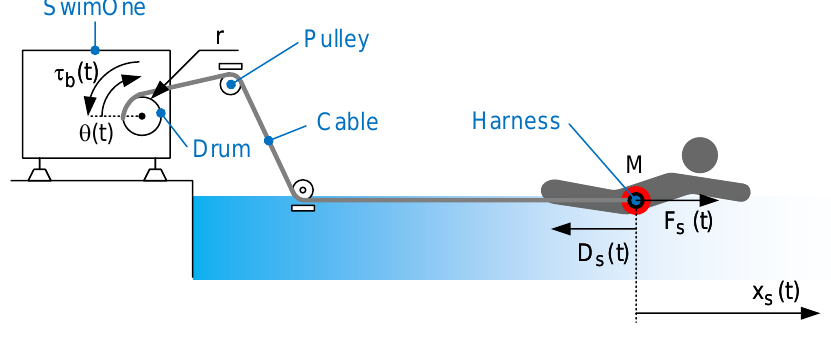
Figure 1. SwimOne: Conceptual